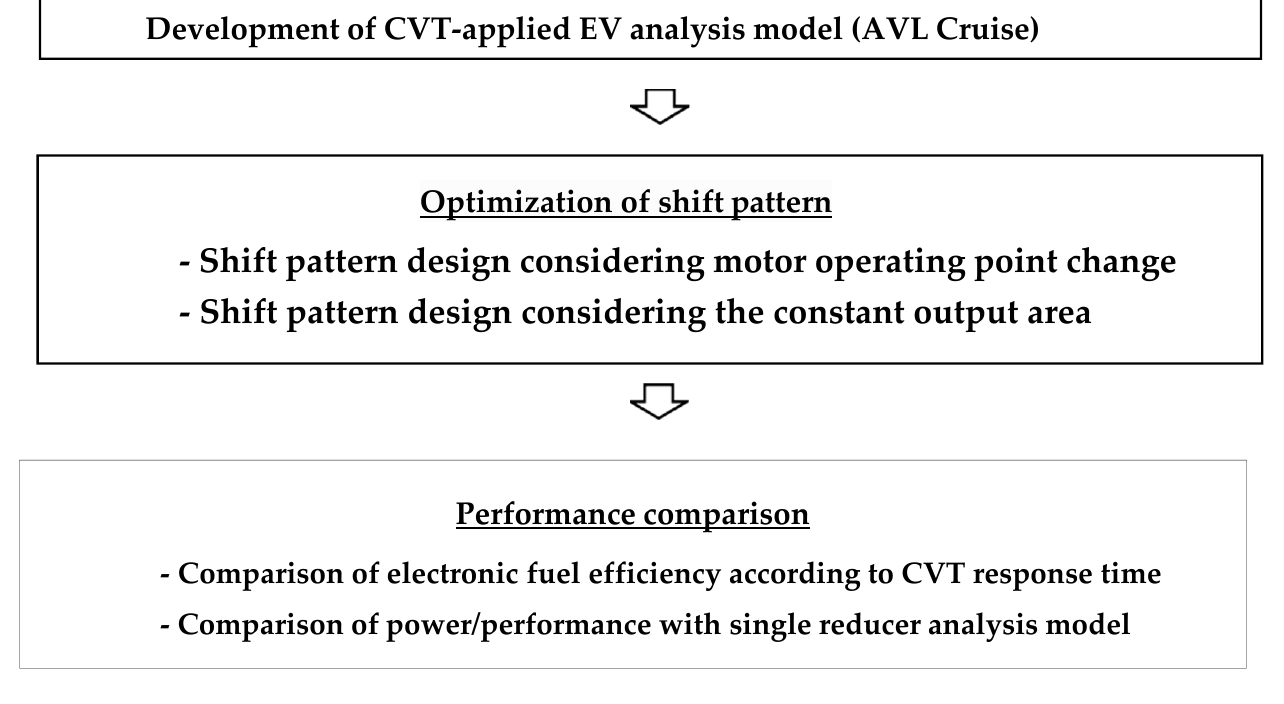
Figure 1. Research process of this study.